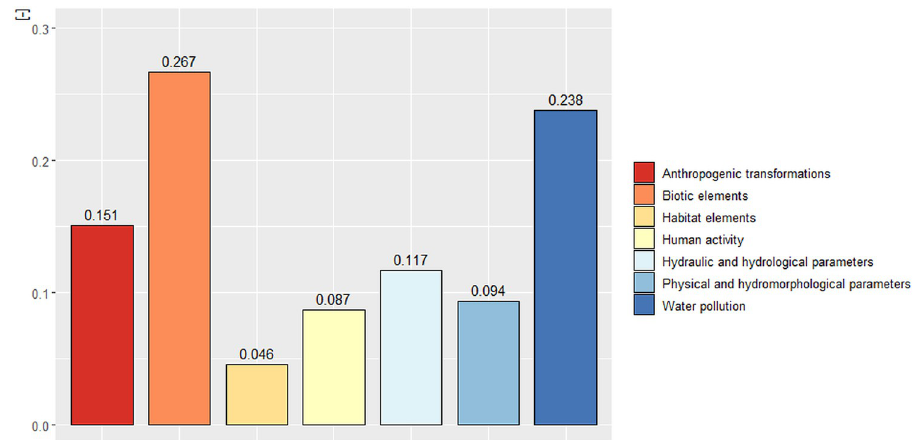
Fig 6. Global vector values for level II of the hierarchical tree.